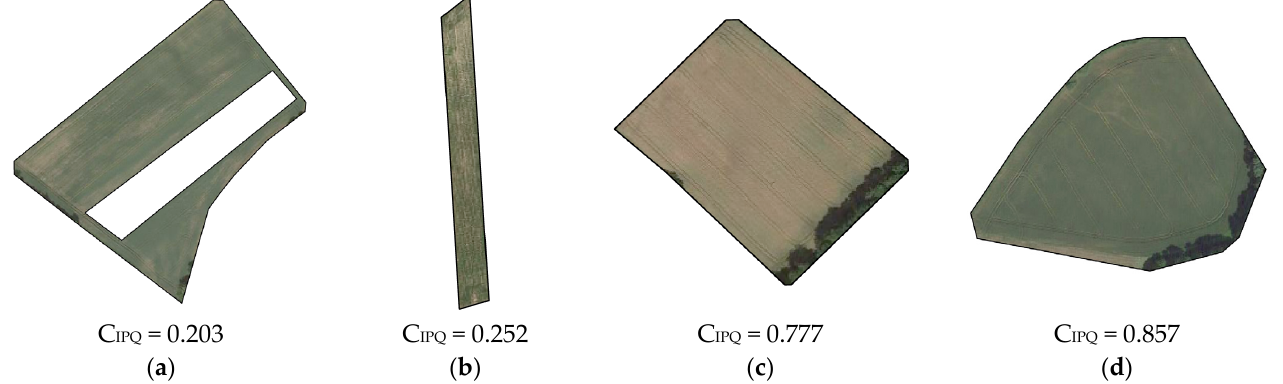
Figure 8. Examples of geometric shapes of arable land parcels in the Fischbach catchment with different values for C IPQ (figures do not have the same scale); ( a ) shape with hole; ( b ) shape with unequal ratio; ( c ) squared shape; ( d ) convex shape; data source: [40,41].